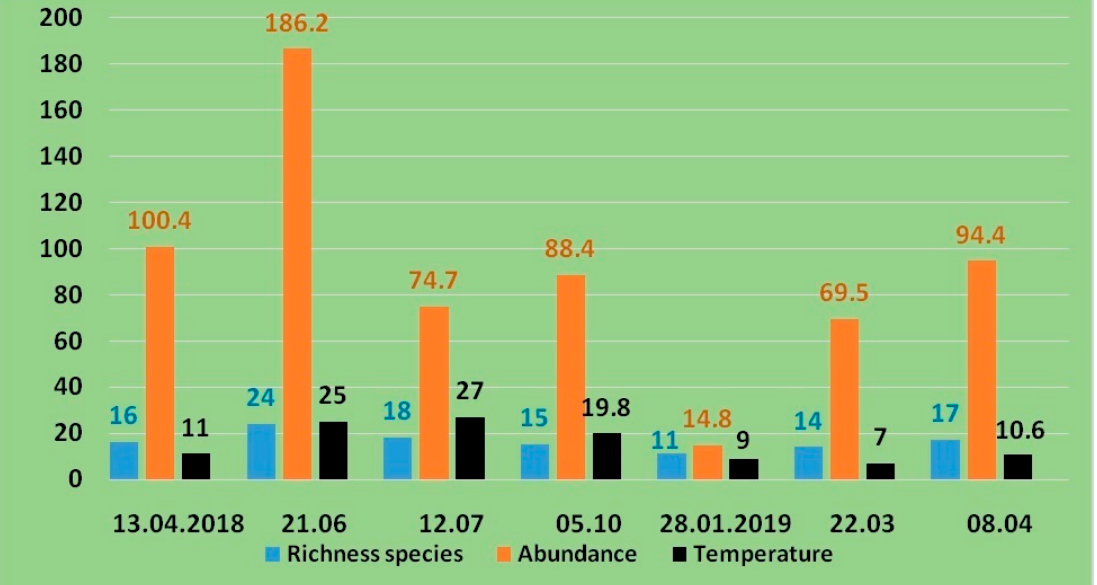
Figure 3. Species richness, abundance of diatoms and water temperature in Donuzlav Gulf of the Black Sea (2018–2019).